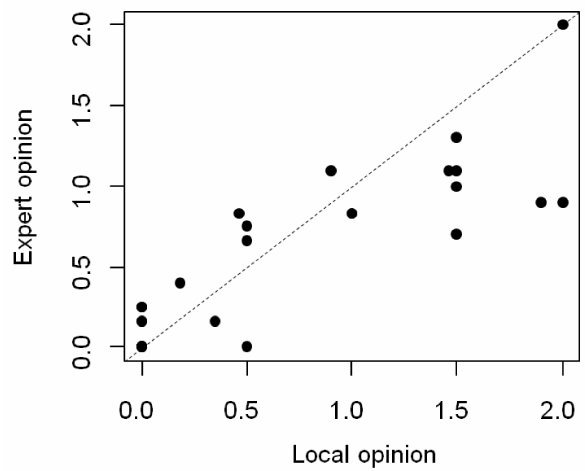
Figure 4. Scatterplot of the averaged opinion on the ability of di ff erent parrot species from Colombia to imitate human speech (0 = lowest, 2 = highest) provided by international experts and by local pet owners. Each dot represents a species, and the dashed line represents the theoretic perfect